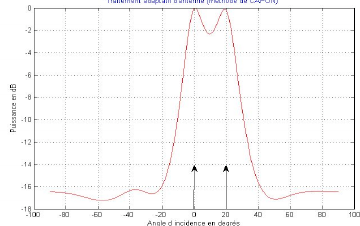
Fig. 7. Direction of arrival of two sources using the adaptive